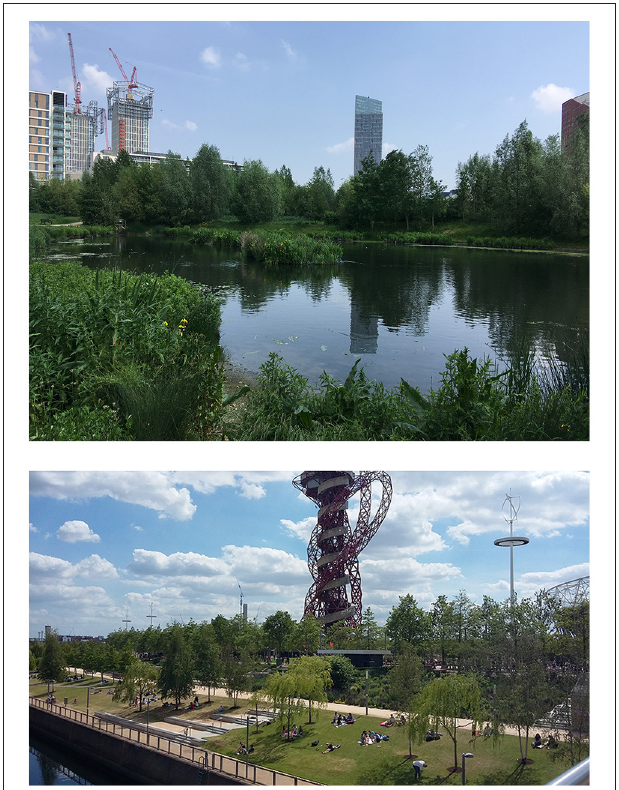
FIGURE 6 | Queen Elizabeth Olympic